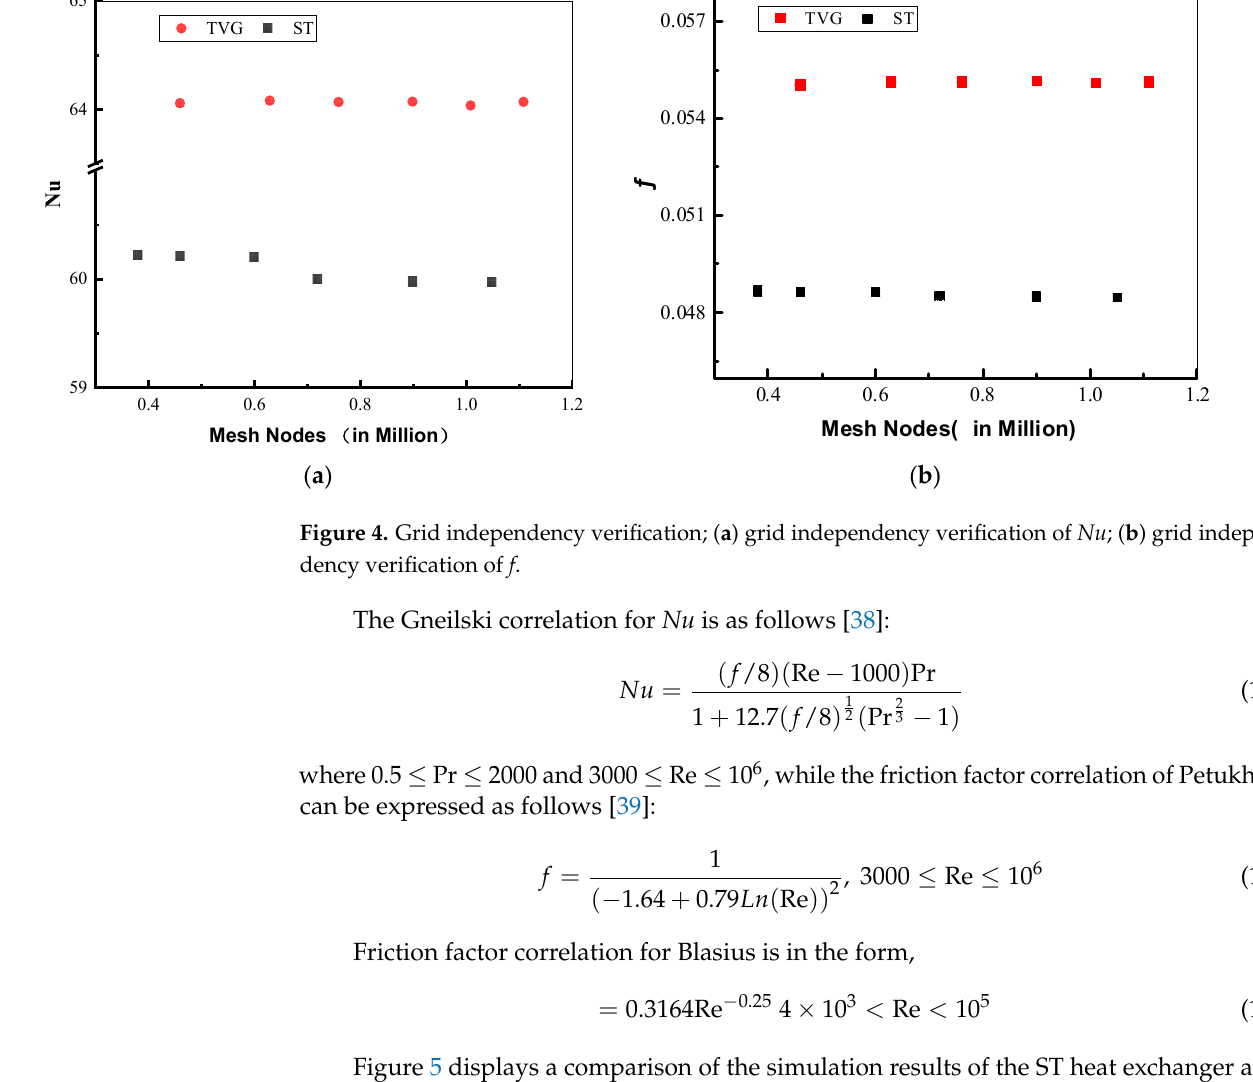
8 of 22 Figure 3. Mesh generation of coaxial borehole heat exchangers. Table 3. Mesh metrics. Geometry Nodes